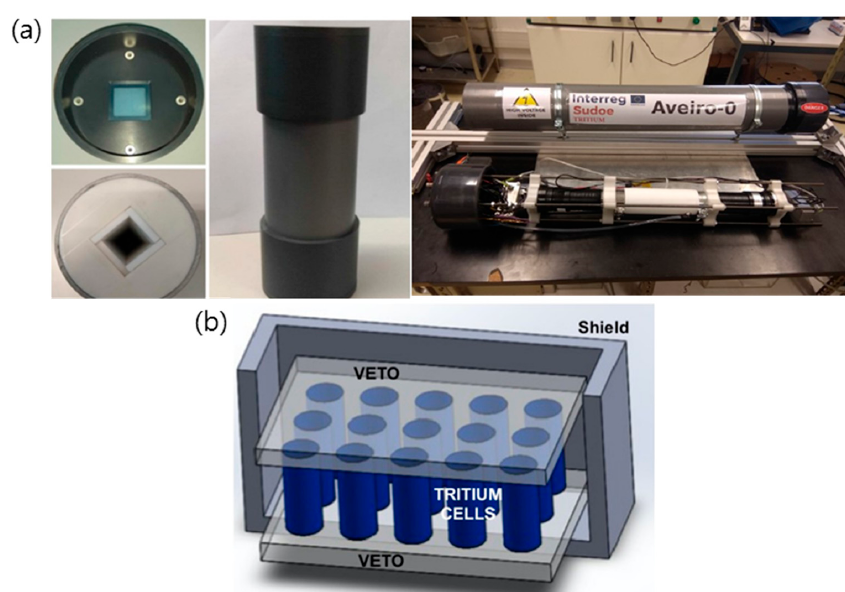
Figure 24. TRITIUM-2 detector: ( a ) TRITIUM-2 probe prototype and ( b ) detection composition with the TRITIUM-2 module [91].